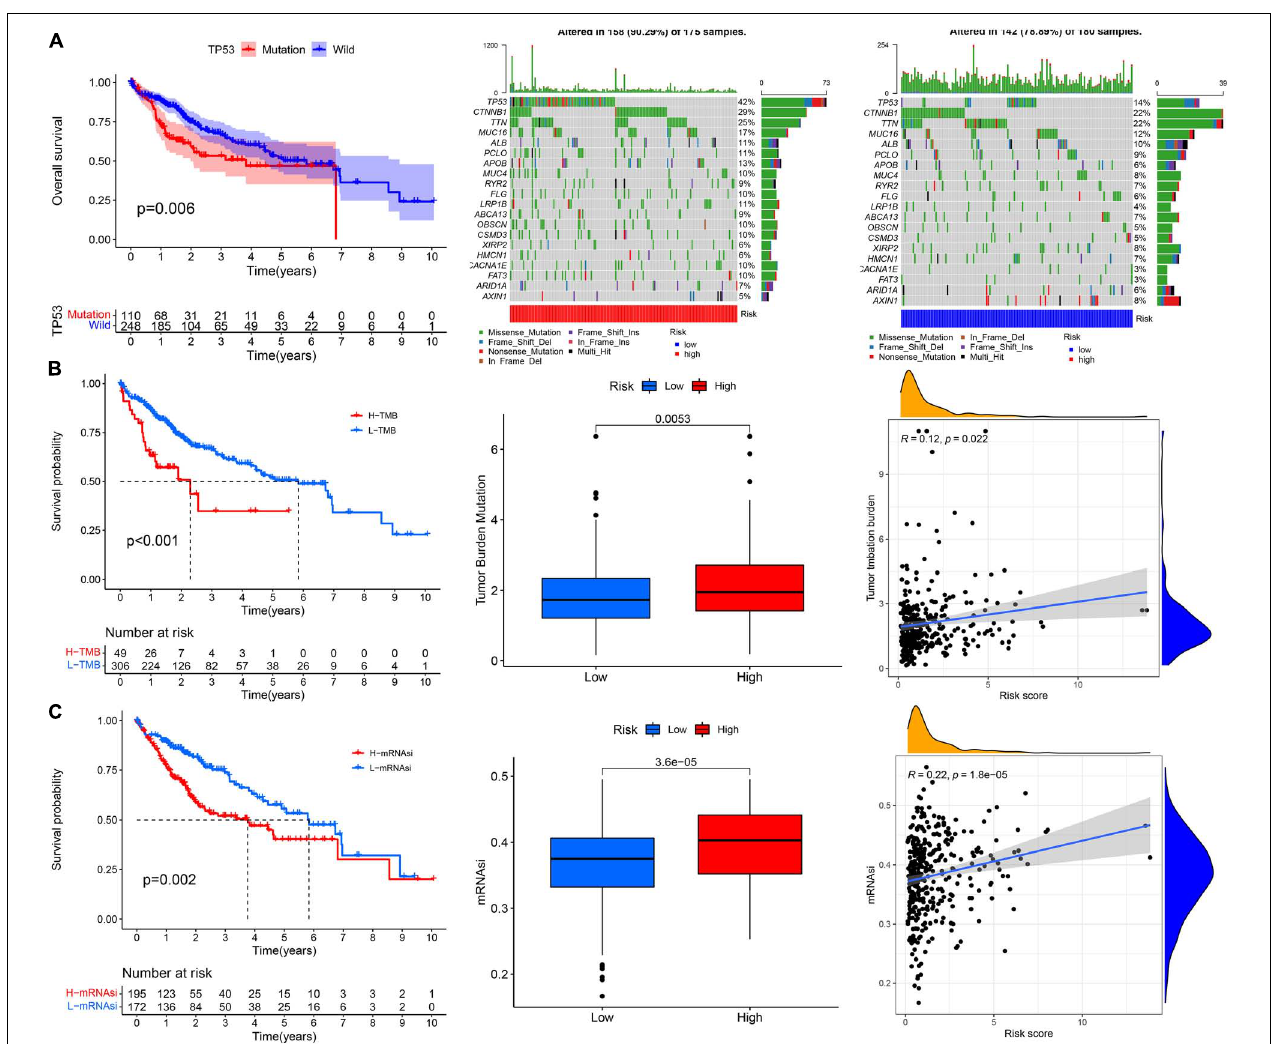
FIGURE 9 | The correlation analysis between the risk score and (A) TP53 mutation, (B) tumor mutation burden, and (C) cancer stem cells indices